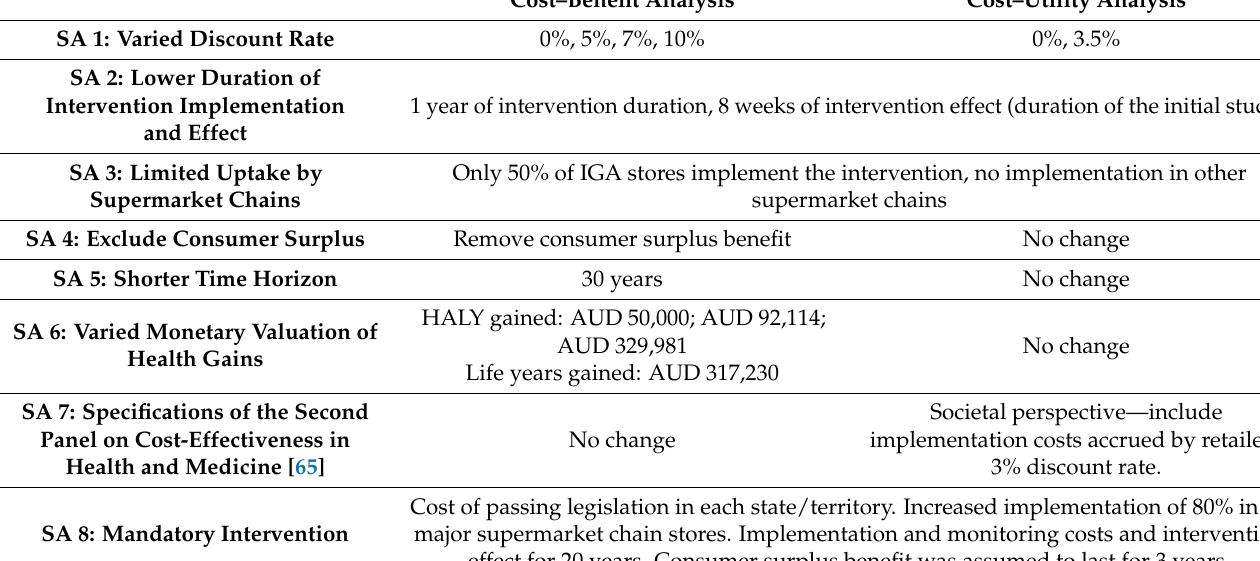
Table 2. Description of sensitivity analyses. Cost–Benefit